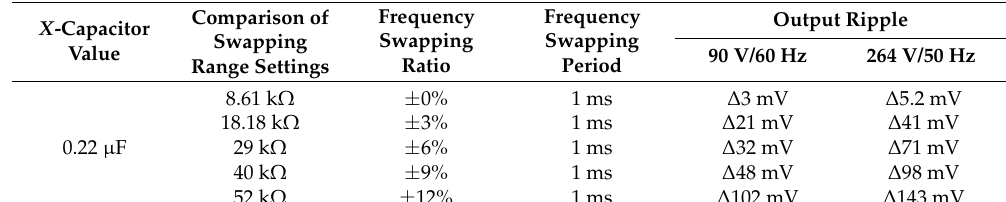
Table 3. Comparison of modified swapping ratios.